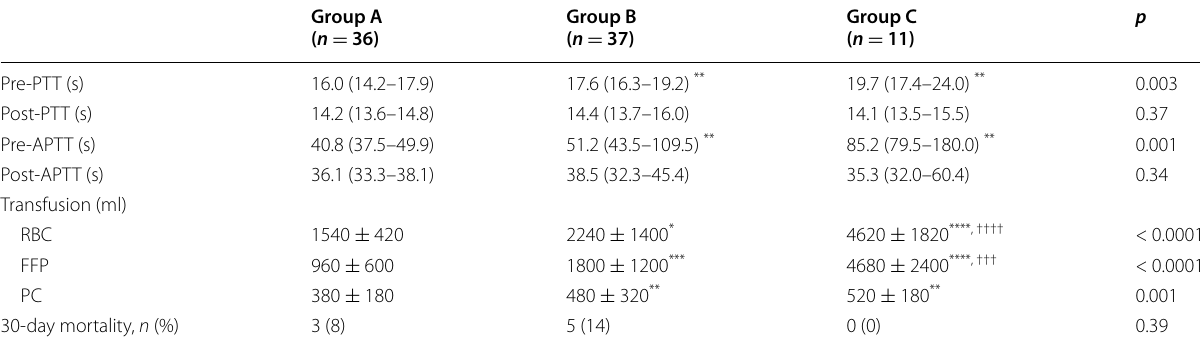
Table 2 Coagulation capacity before and after administration of cryoprecipitate, intraoperative blood transfusion volume, and